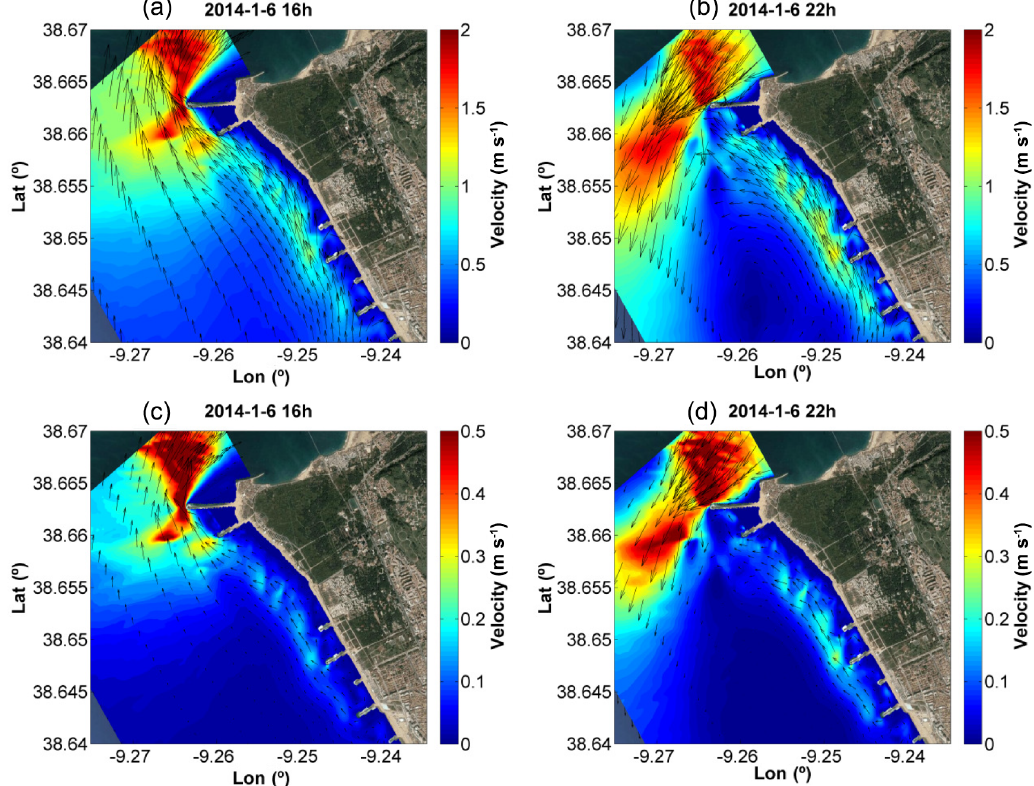
Figure 14. Velocity results of the Costa da Caparica model during flood (a, c) and ebb (b, d) tides at the surface (a, b) and near the bottom (c, d) considering the wave’s effect on the